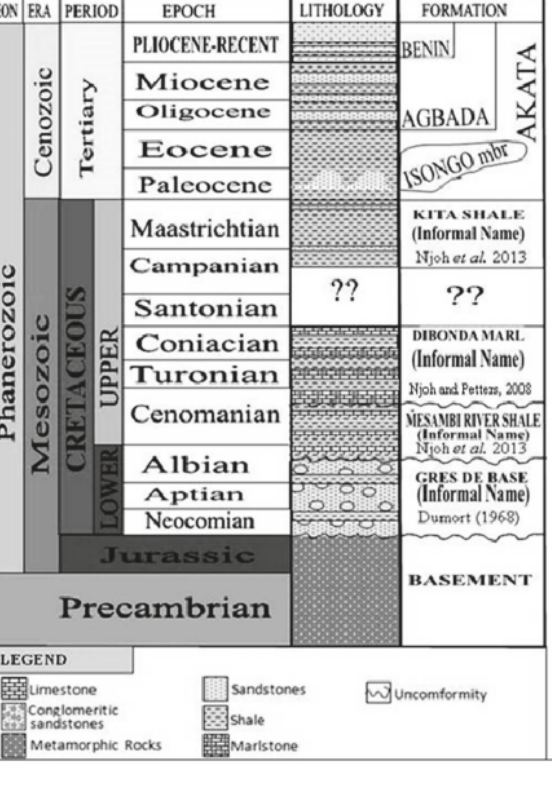
Figure 3: The lithostratigraphic framework of the Rio del Rey Basin with the Cretaceous section still under